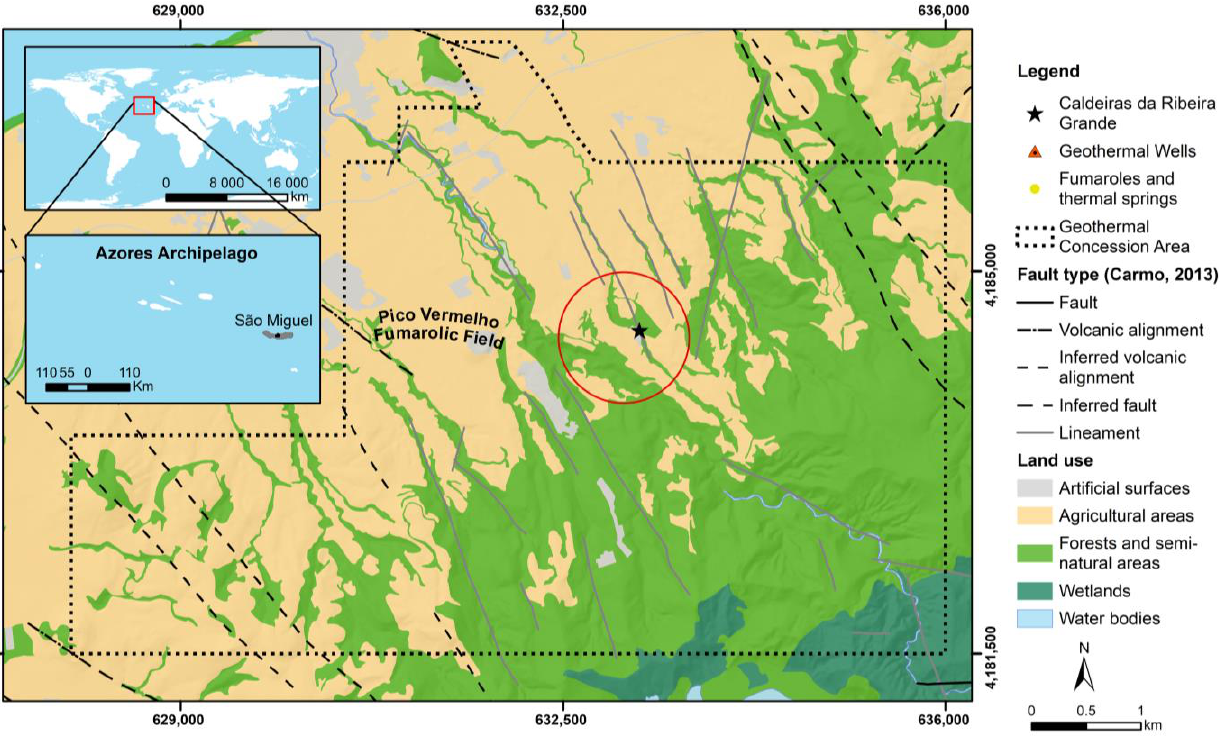
Figure 1. Land-use map (based on [37] and the geographic location of the Ribeira Grande geothermal field) with the existing geothermal wells (based on the studies of [23,38,39]), the main fumarolic emissions [35], and fault type (based on [40]).